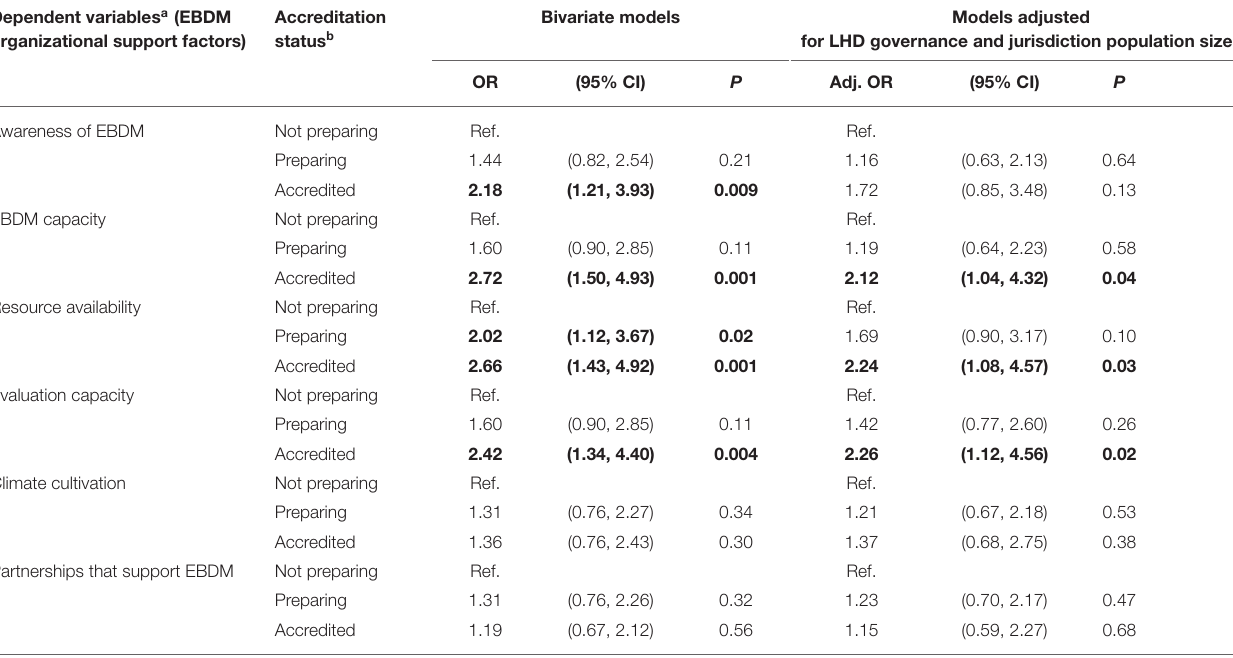
TABLE 3 | Odds ratios of highest tertile of evidence-based decision making (EBDM) factors (dependent variables) by accreditation status in separate logistic regression models among U.S. local health departments, 2017 ( n = 350). Dependent variables a (EBDM organizational support